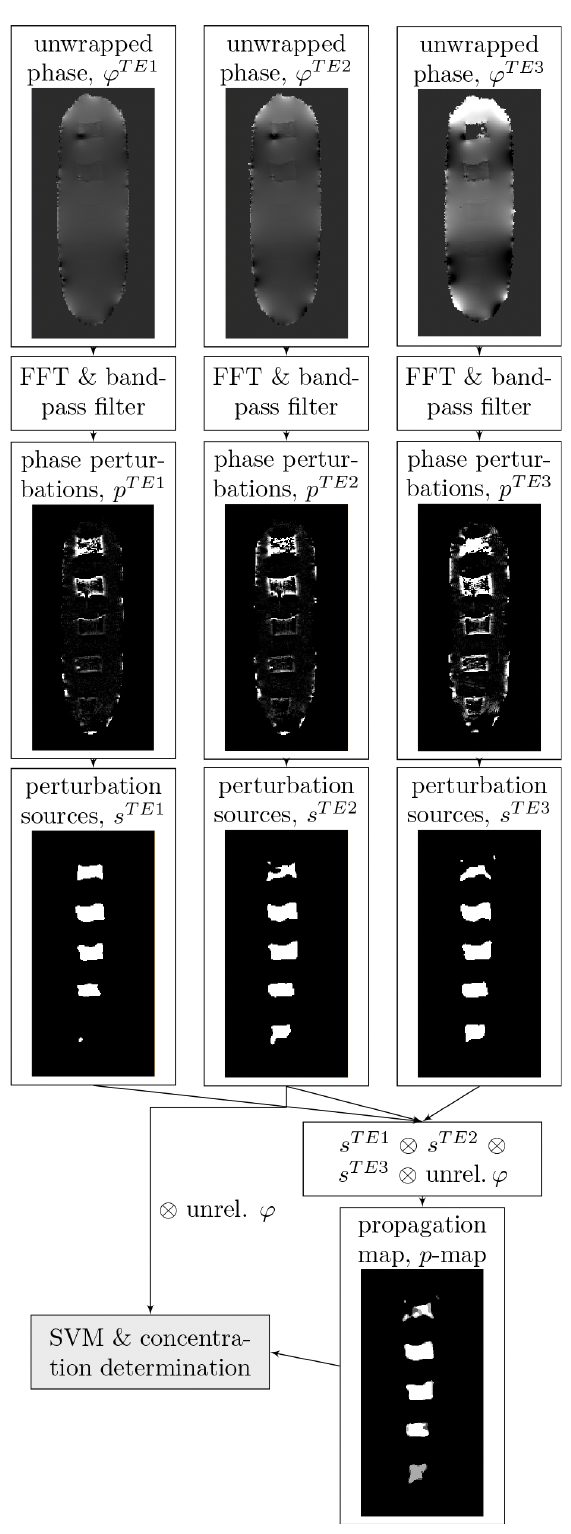
Fig 3. Overview of the feature extraction workflow from phase ( φ